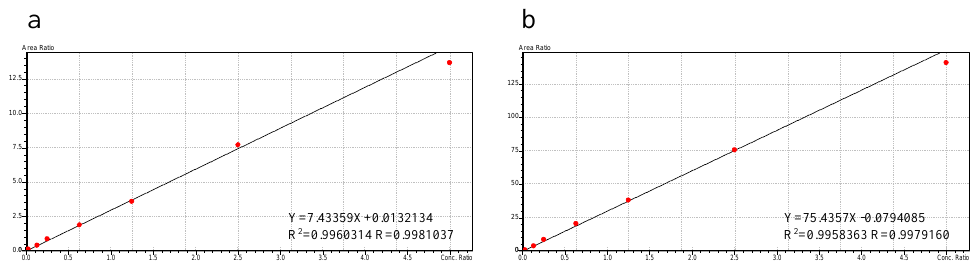
Figure 5. Representative calibration curves for PTU ( a ) and PTU-GLU ( b ).